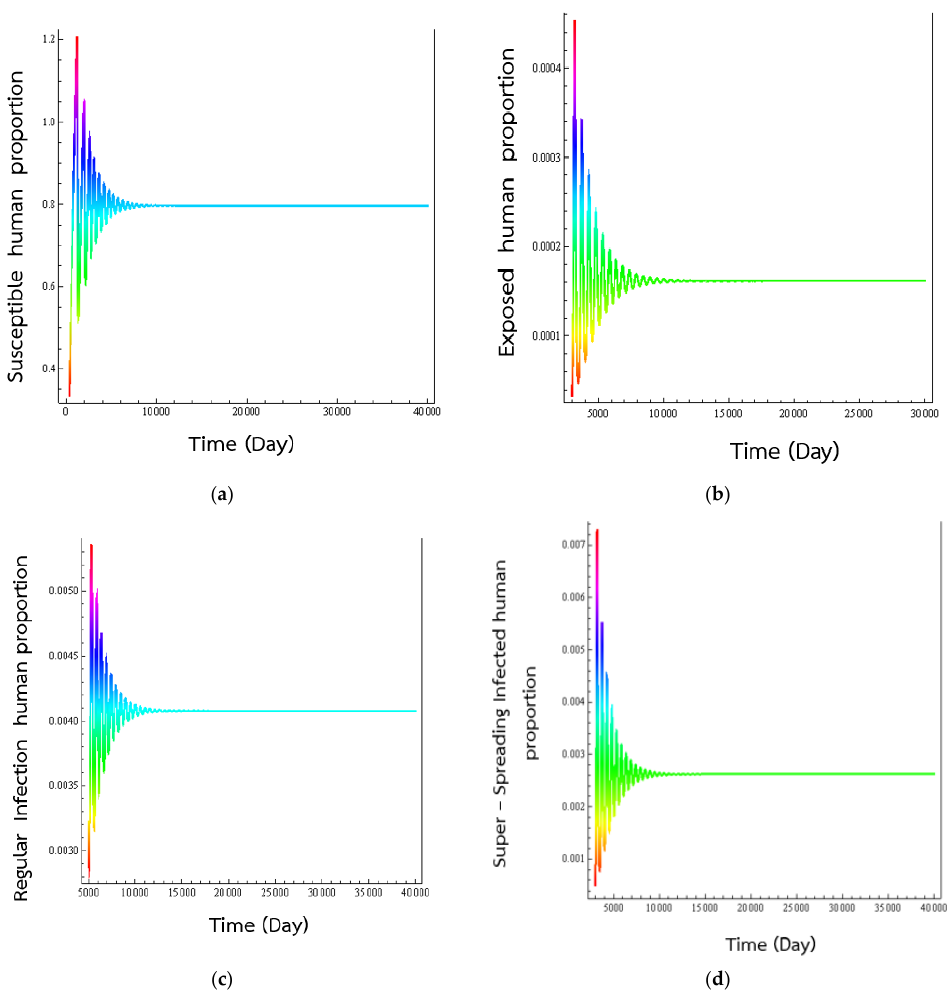
Figure 6. Numerical solution of Equations (2.1)–(2.5) where p = 0.04. Time series behave of ( a ) sus- ceptible human population, ( b ) exposed human population, ( c ) regular infected humans, and ( d ) super-spreading infected humans to the transmission of respiratory disease. The simulated human populations converge to the endemic equilibrium states ),,,( ***** 2 sr IIES =ζ at (0.79734, 0.00016, 0.00408, 0.00262).